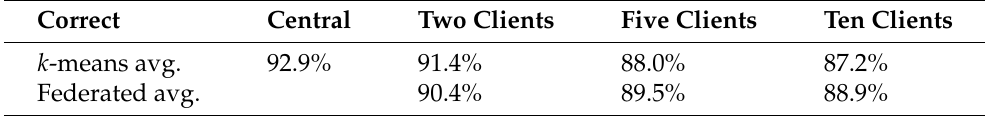
Table 3. Correct cluster guesses with different numbers of clients (DB index below